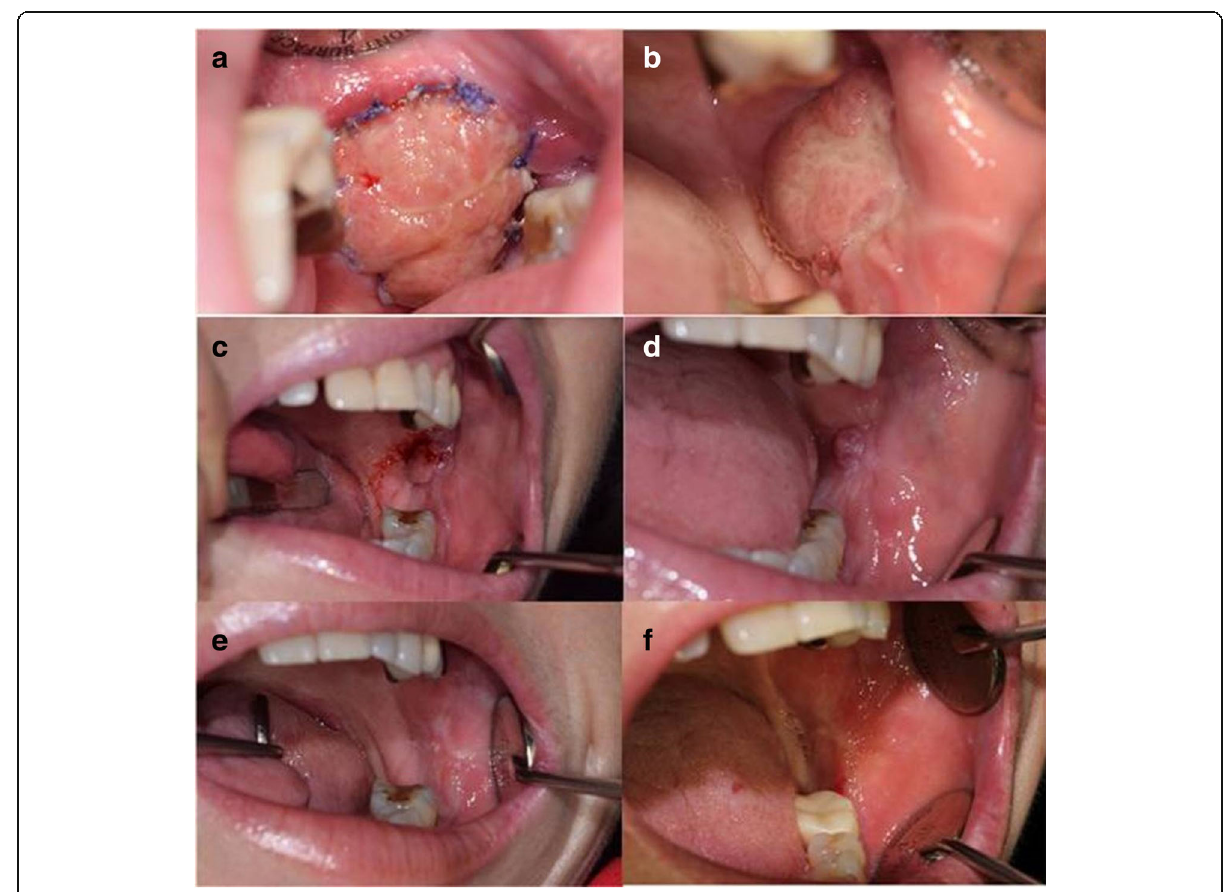
Fig. 3 Re-epithelialization of the grafted buccal fat pad after operation. a . The ninth day. b After 3 weeks. c After 1 month. d After 2 months. e After 3 months. f After 1 year